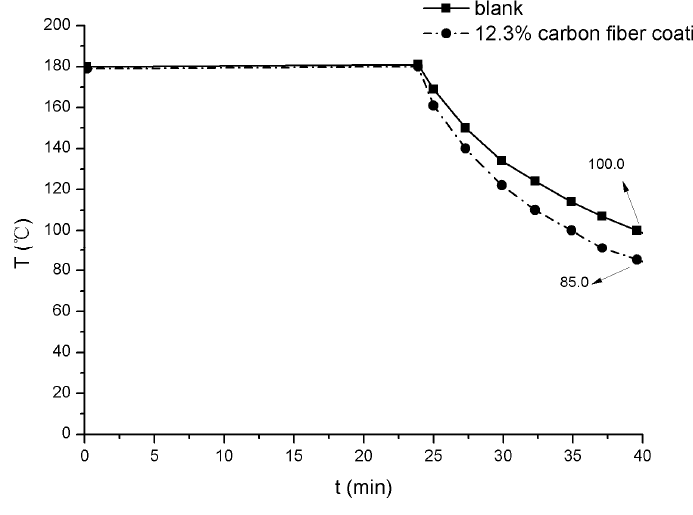
Figure 8. Comparison of cooling curves with or without filler.